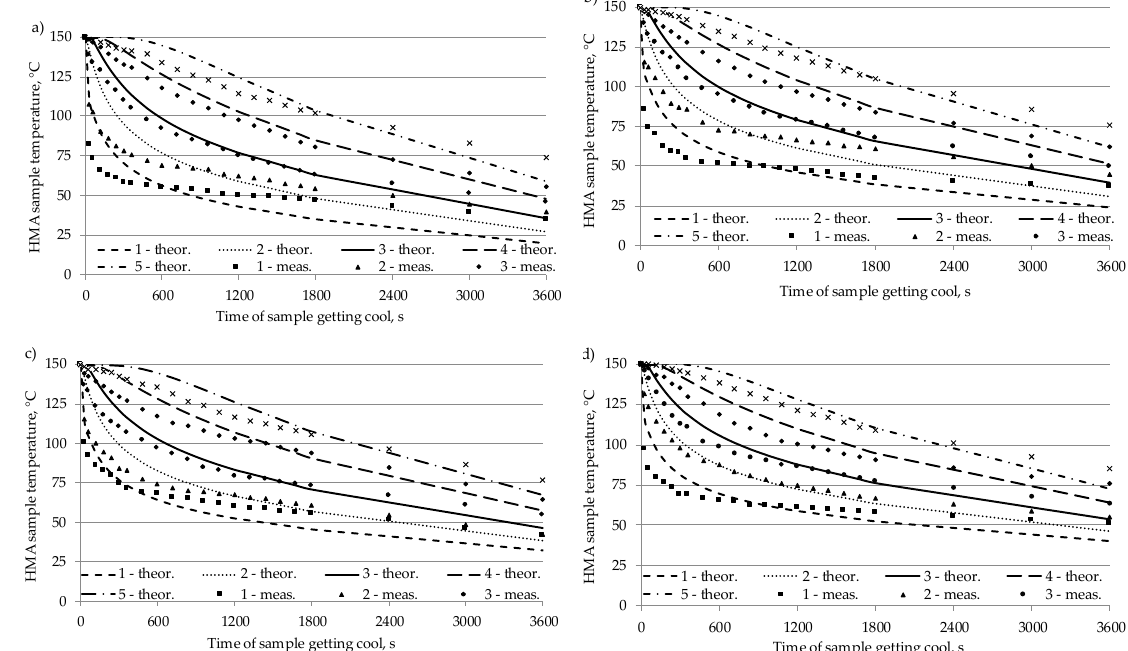
Figure 14. Drops of temperature in AC 11 S specimen over time for different ambient air temperatures: a) 0 °C, b) 5 °C, c) 15 °C, d) 25 °C. Legend: 1, 2, 3, 4, 5 – measurement points according to Figure 8, theor. – theoretical temperature obtained from the model, meas. – measured temperature.